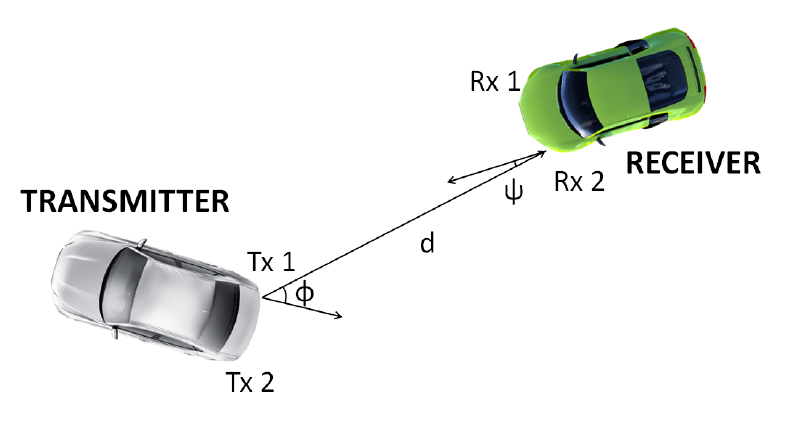
Figure 2. Relative positioning of a transmitter (left vehicle) and a receiver (right vehicle).